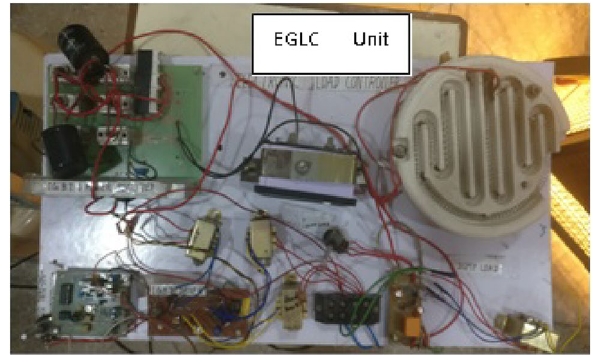
Fig. 4 Photograph of the Electronic Generator Load Controller (EGLC)